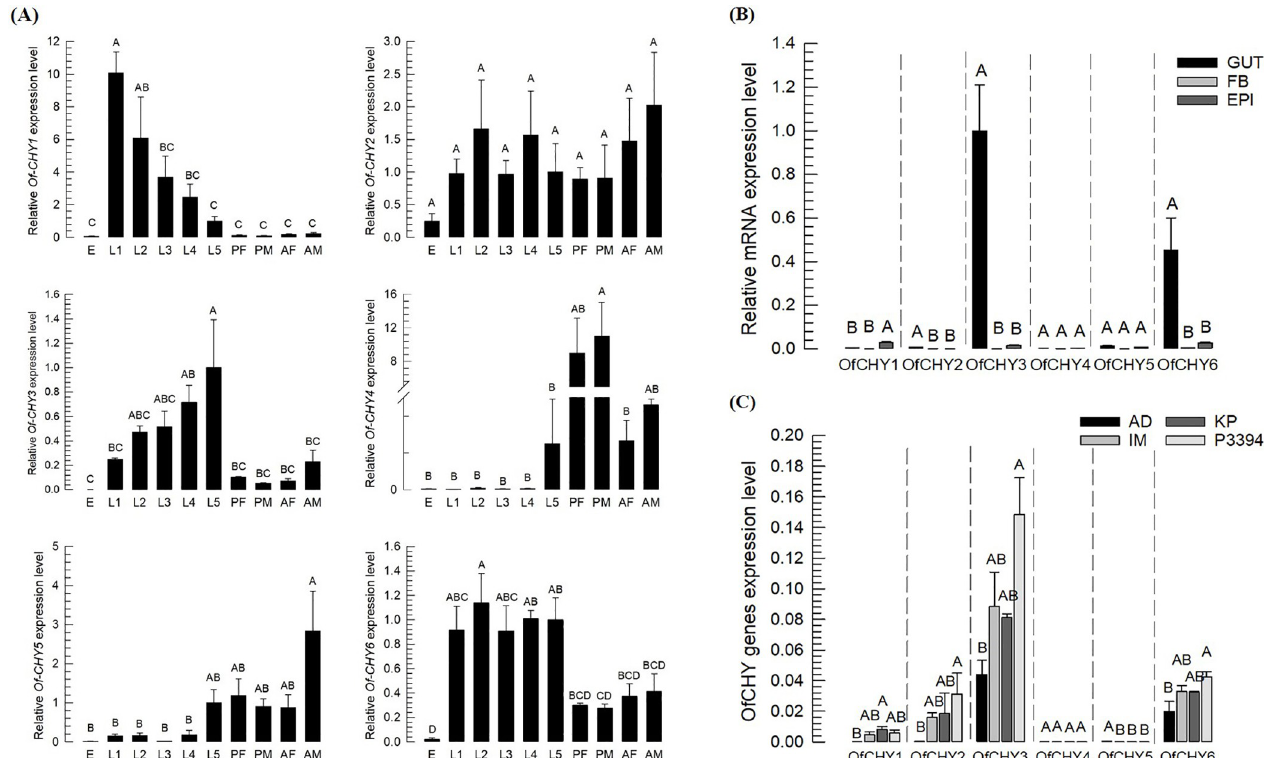
Fig 5. Expression patterns of six chymotrypsin genes ( Of-CHY1~Of-CHY6 ) in O . furnacalis . (A) RT-PCR and RT-qPCR analyses of genes in different developmental stage: Larvae (‘L1–L5’), female and male pupae (‘PF’ and ‘PM’), and female and male adults (‘AF’ and ‘AM’). Each treatment was replicated three times. For each replication, 100 eggs, 20 L1 larvae, ten L2 larvae, five L3 larvae, three L4 larvae, one L5 larva, one pupa, and one adult of each sex was used to extracted total RNA. (B) RT-PCR and RT-qPCR of six Of-CHY genes in different tissues of O . furnacalis reared on artificial diet. Each treatment was replicated three times. For each replication, three L5 larvae was used to extracted total RNA in different tissues: ‘GUT’ for midgut, ‘FB’ for fat body, and ‘EPI’ for epidermis. (C) RT-PCR and RT-qPCR of six Of-CHY genes after different diet treatments. Diet treatments included artificial diet (‘AD’) and three corn varieties including Ilmichal (‘IM’), Kwangpyeongok (‘KP’), and P3394. Each treatment was replicated three times. For each replication, gut of three L5 larvae reared with different diet was used to extracted total RNA. Different letters above standard error bars indicate significant difference among means at Type I error = 0.05 (Tukey